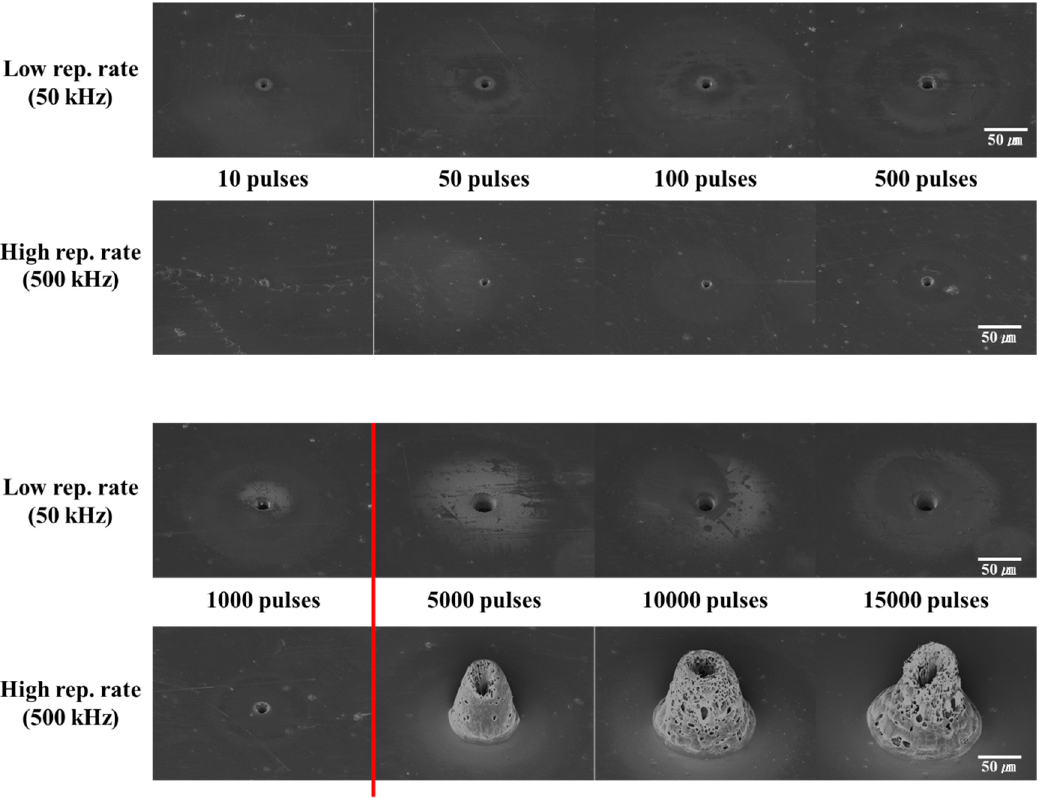
Figure 6. SEM images of laser processing results of polyimide (PI) under stationary beam irradiation with the same average power.